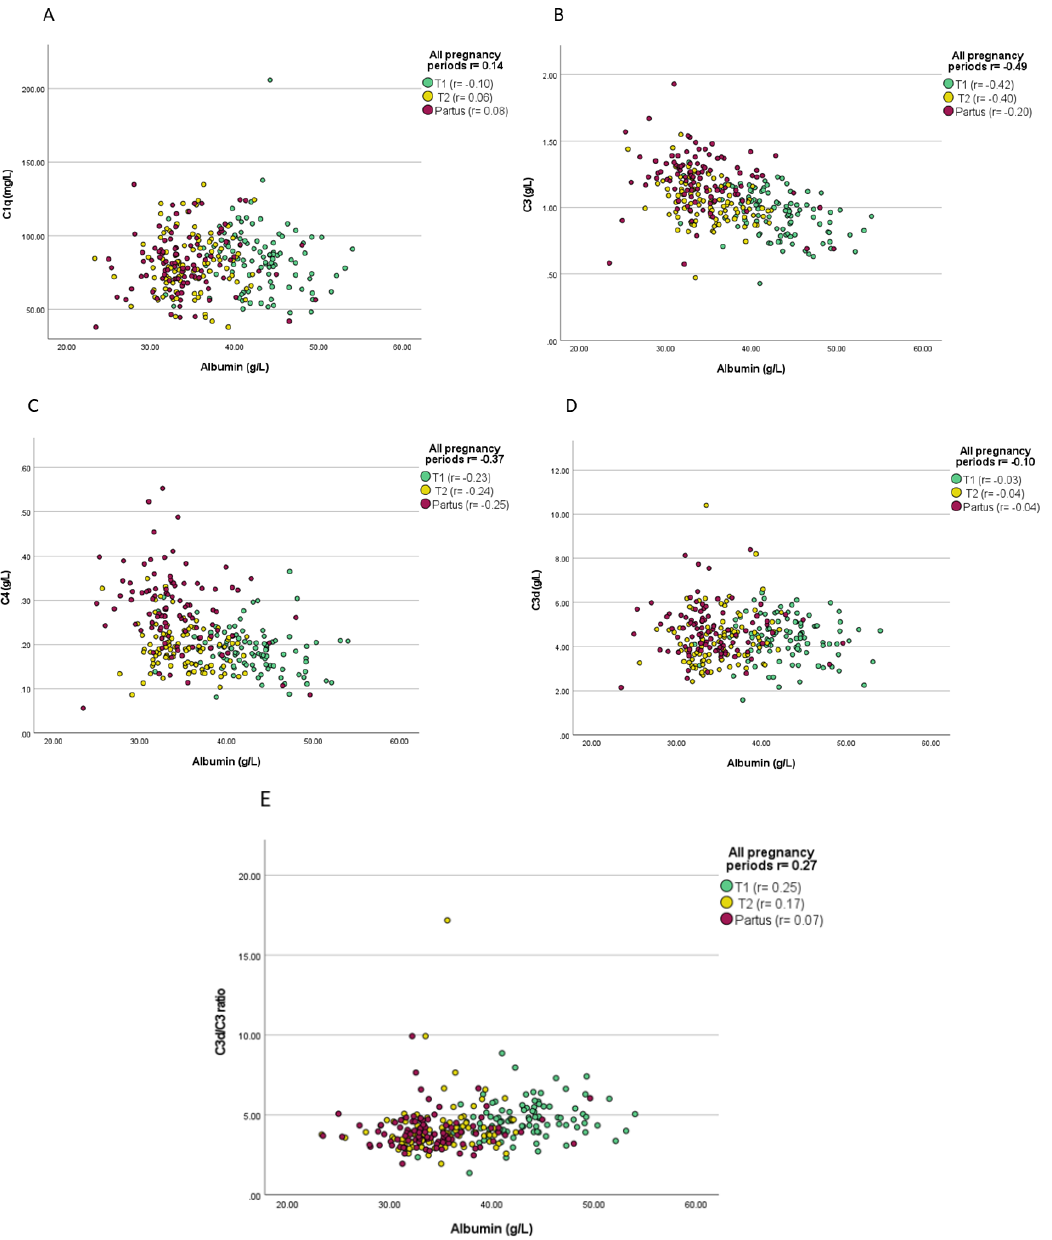
Figure 2. ( A – E ) Correlations of plasma albumin levels and different complement levels throughout the pregnancies. Correlation coefficients and significance levels are given both for merged data and for all sampling occasions. Table 3. Associations between complement protein levels and studied variables.